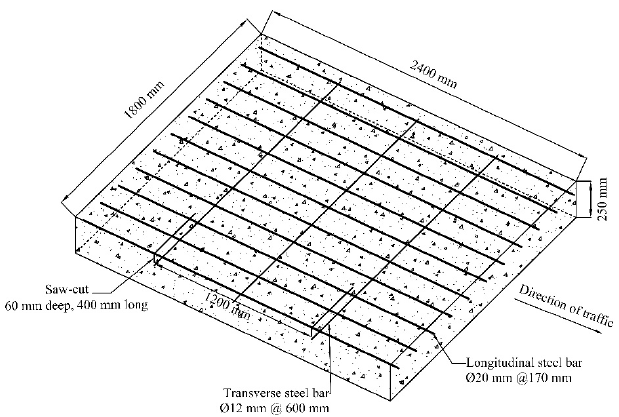
Figure 7. Geometry details of the CRCP segment.